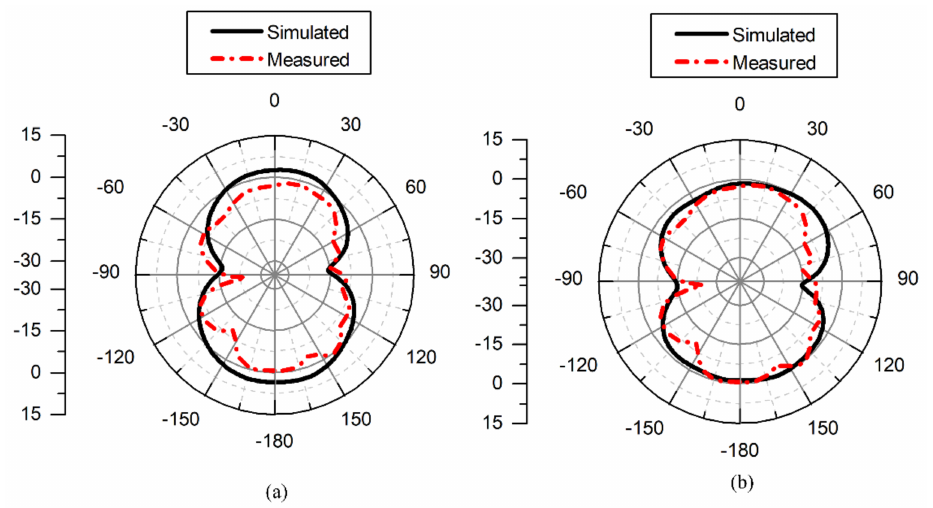
Figure 14. Radiation pattern for the mid-band MIMO antenna: ( a ) measured and simulated radiation pattern for phi = 90 ◦ at 3.8 GHz; ( b ) measured and simulated radiation pattern for theta = 90 ◦ at 3.8 GHz.